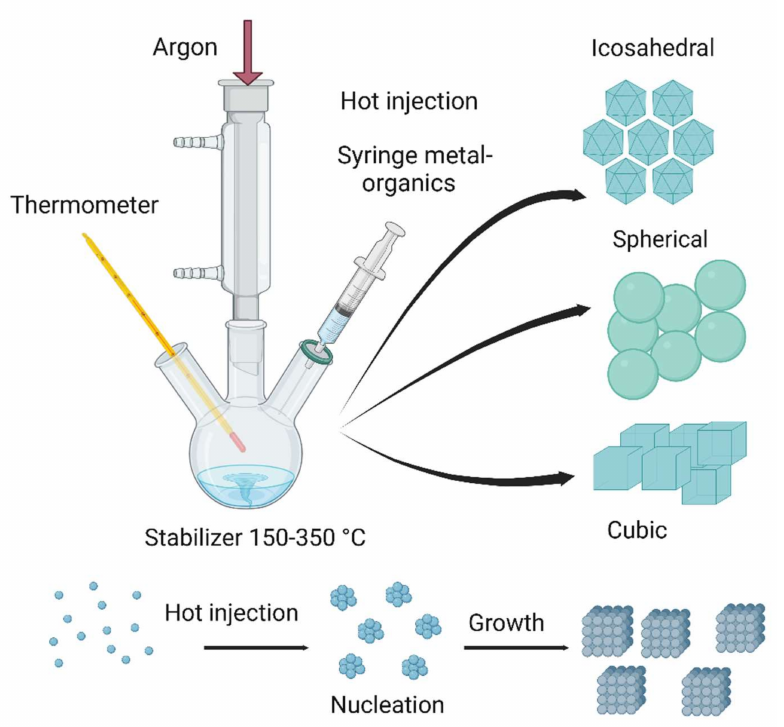
Figure 8. Schematic representation of the hot injection synthesis of nanocrystals. Image created with